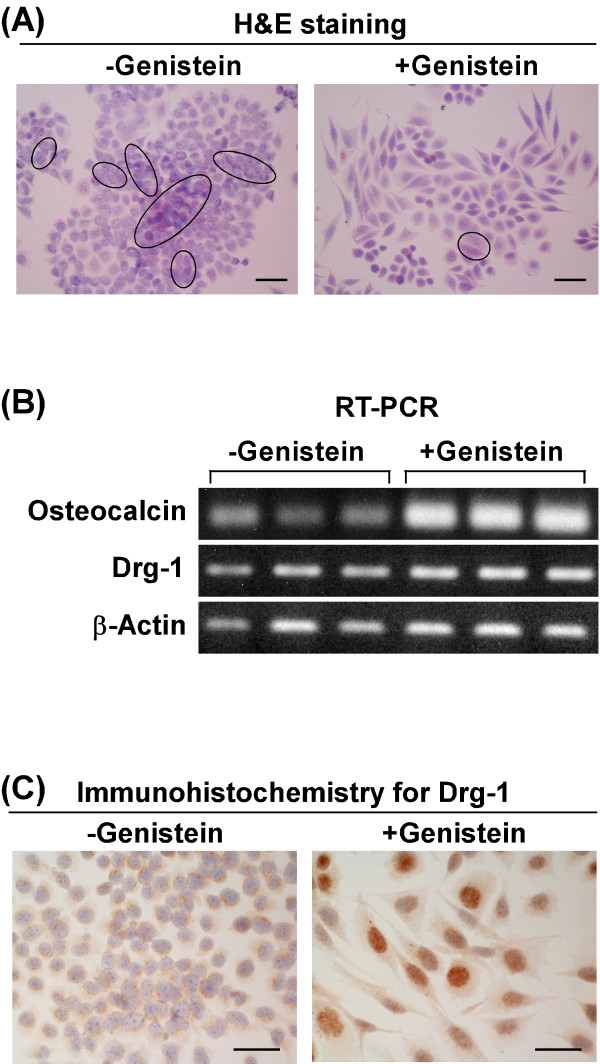
Effect of genistein on differentiation of LM8 cells. (A) LM8 cells were treated for 3 days without (left panel) or with (right panel) 50 μM genistein, fixed with ethanol, and stained with H&E. Scale bar: 50 μm. (B) LM8 cells were treated for 3 days without or with 50 μM genistein, and the expression of mRNAs of osteocalcin, Drg-1, and β-actin was examined by RT-PCR. (C) LM8 cells were treated for 3 days without (left panel) or with (right panel) 50 μM genistein, and immunohistochemical staining of Drg-1 was performed. Scale bar: 50 μm.